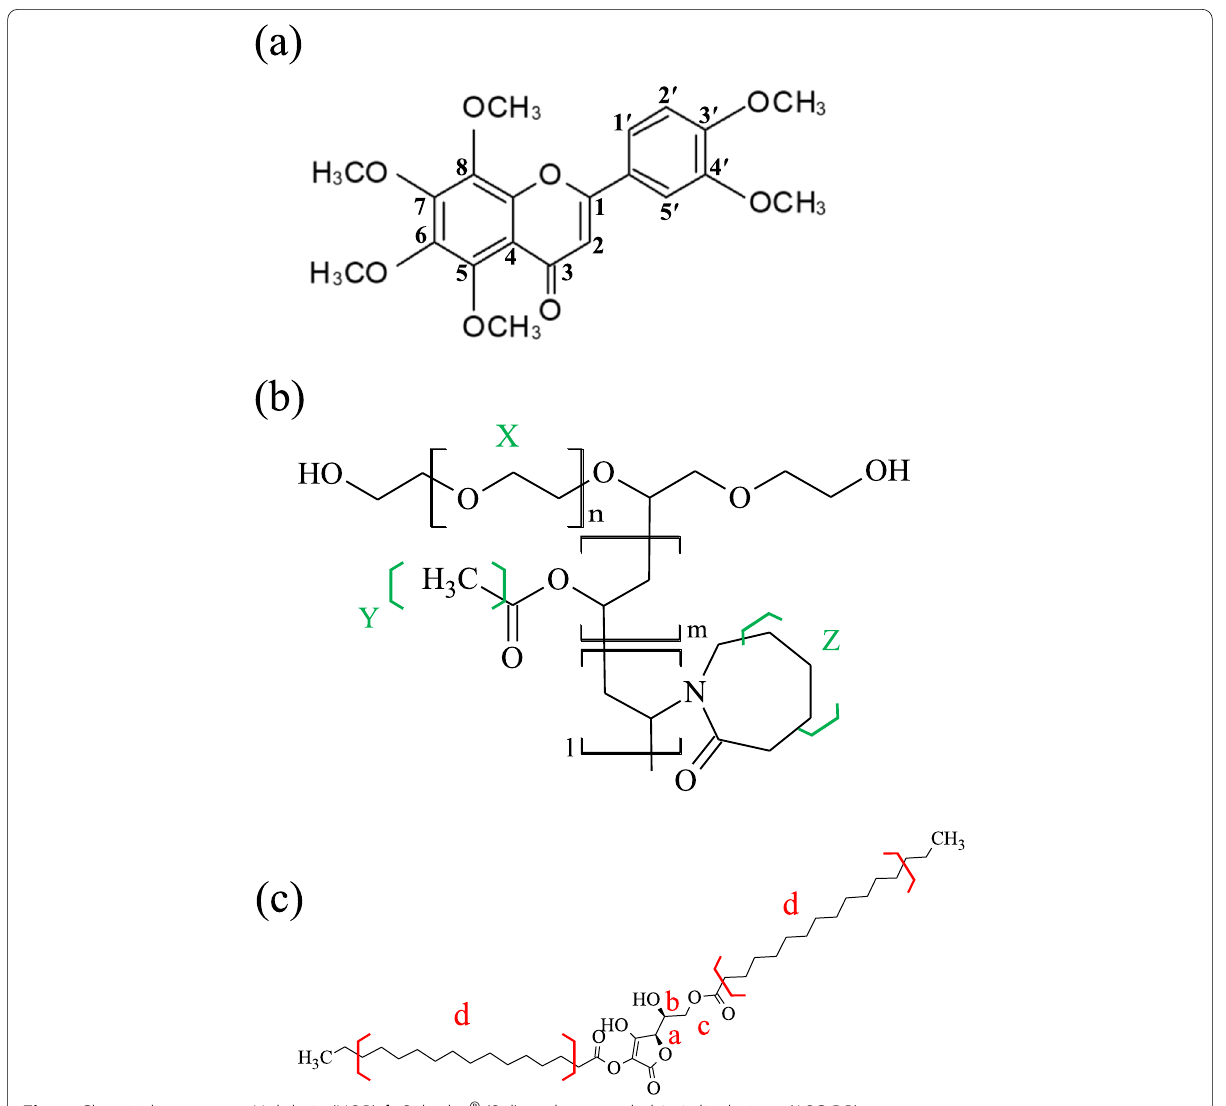
Fig. 1 Chemical structure. a Nobiletin (NOB), b Soluplus ® (Sol), and c l -ascorbyl 2, 6-dipalmitate